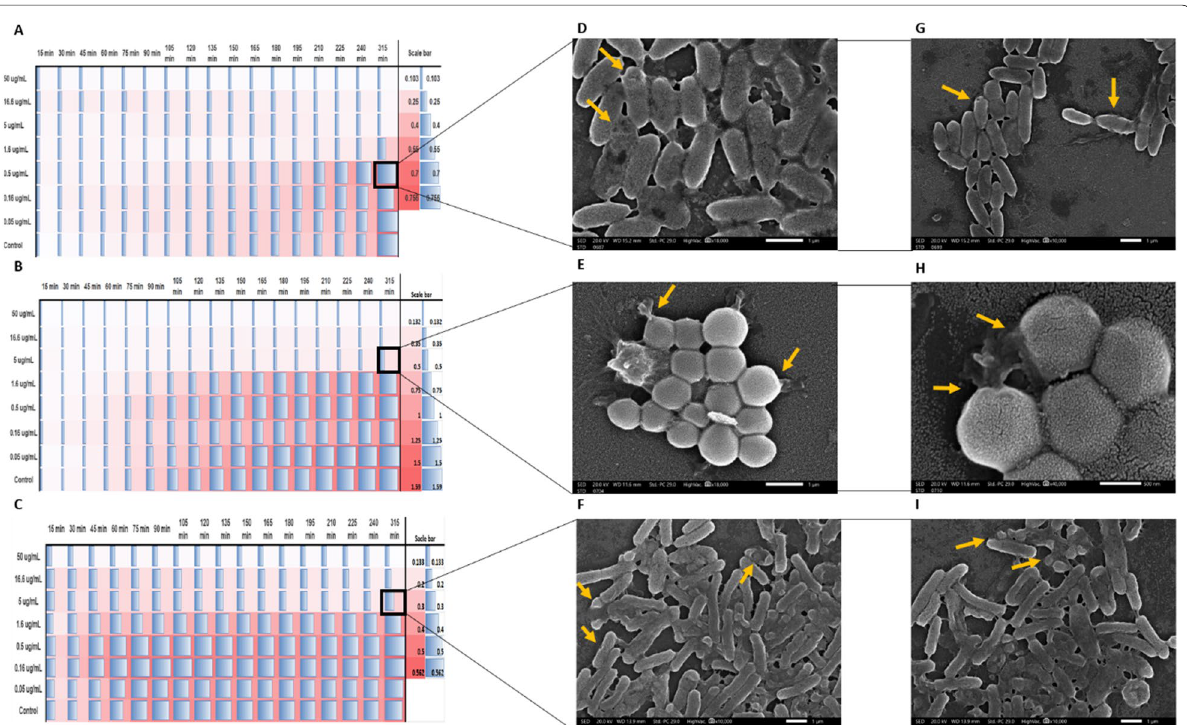
Fig. 7 A heatmap and SEM images for the bacteria damage after adding the Au@AgNPs. The heat map of A P. aeruginosa B S. sciuri C S. enterica . The SEM images for the bacterial damage in the cell membrane of D , G P. aeruginosa , E , H S. sciuri , and F , I S. enterica after exposure to the Au@AgNPs in the concentrations marked in the black box ( A – C ). The orange arrows refer to the damage to the cell membrane